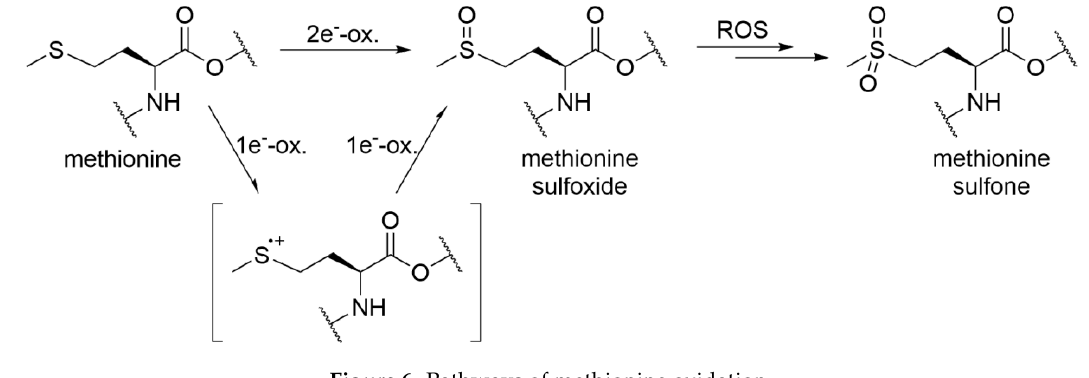
Figure 6. Pathways of methionine oxidation.